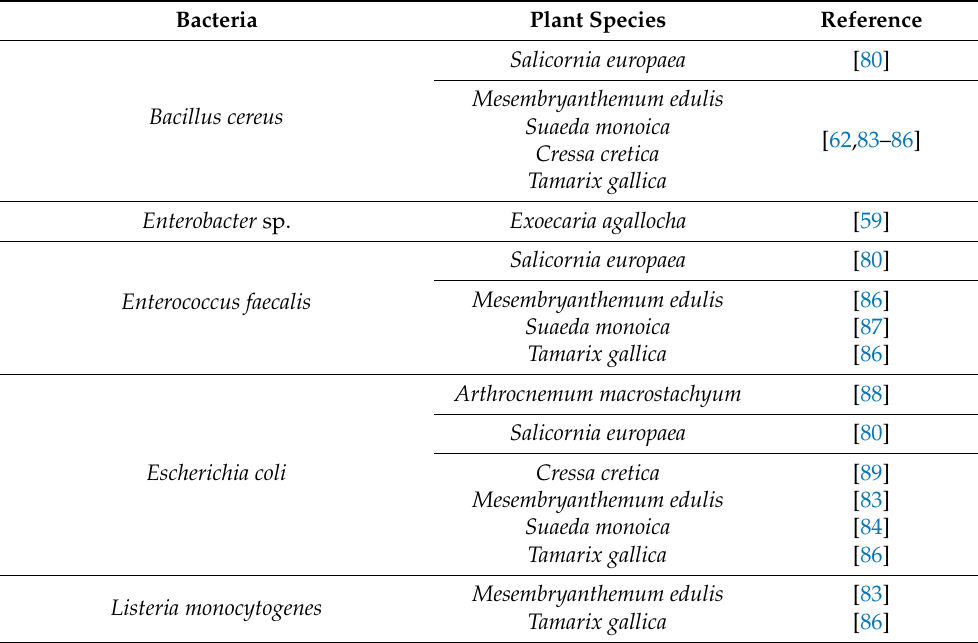
Table 3. Antibacterial effects associated with extracts of halophyte